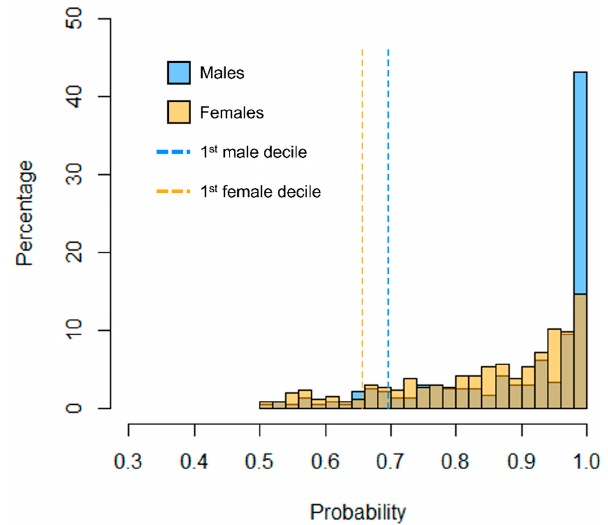
Figure 7. Distribution of the probabilities returned by the best model for correctly estimated females (orange) and males (blue). The dashed vertical lines show the first decile of probability, which indicates the probability above which 90% of observations are estimated.